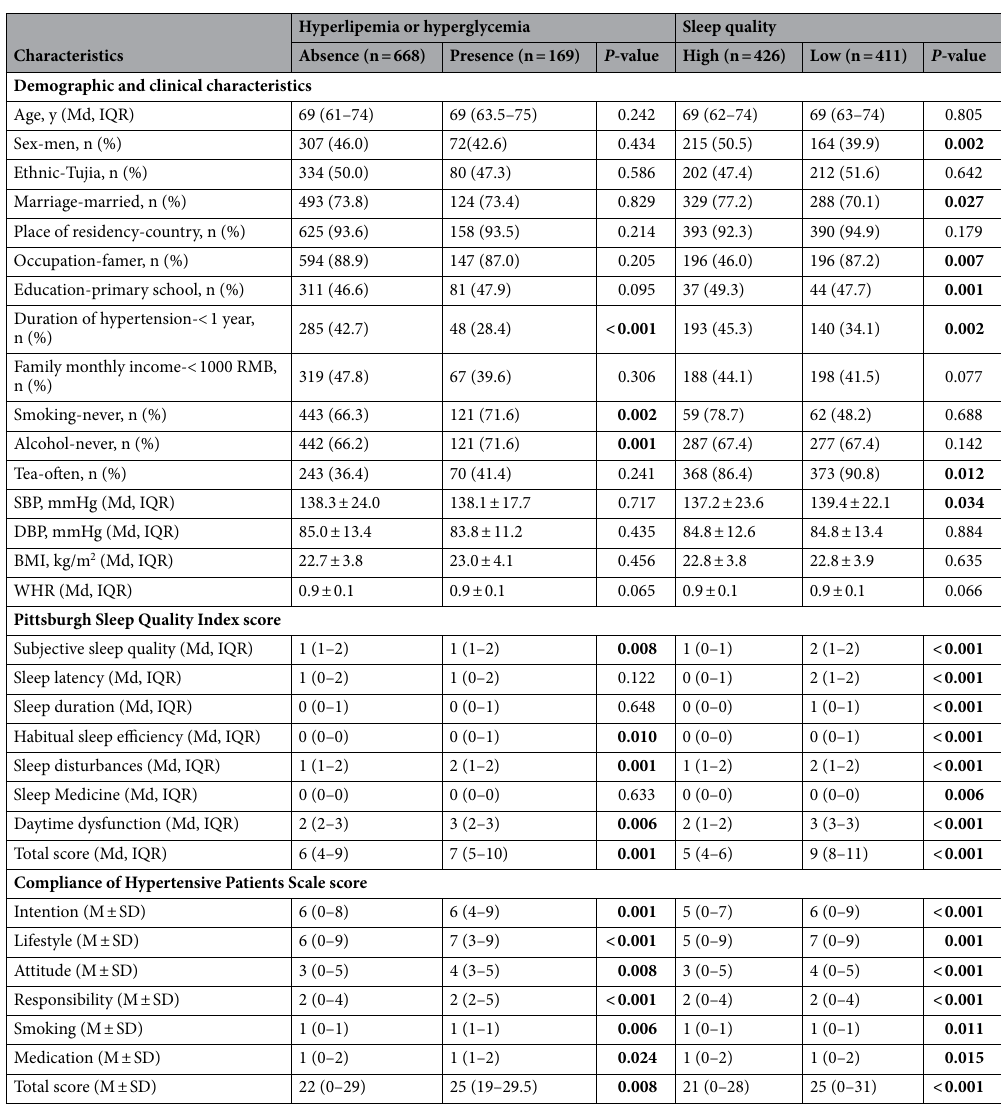
Table 2. Participants’ characteristics in hyperlipemia/hyperglycemia and sleep quality. Md median, IQR interquartile range, SBP systolic blood pressure, DBP diastolic blood pressure, BMI body mass index, WHR waist-to-hip ratio. Significant differences ( P < 0.05) are highlighted in bold.